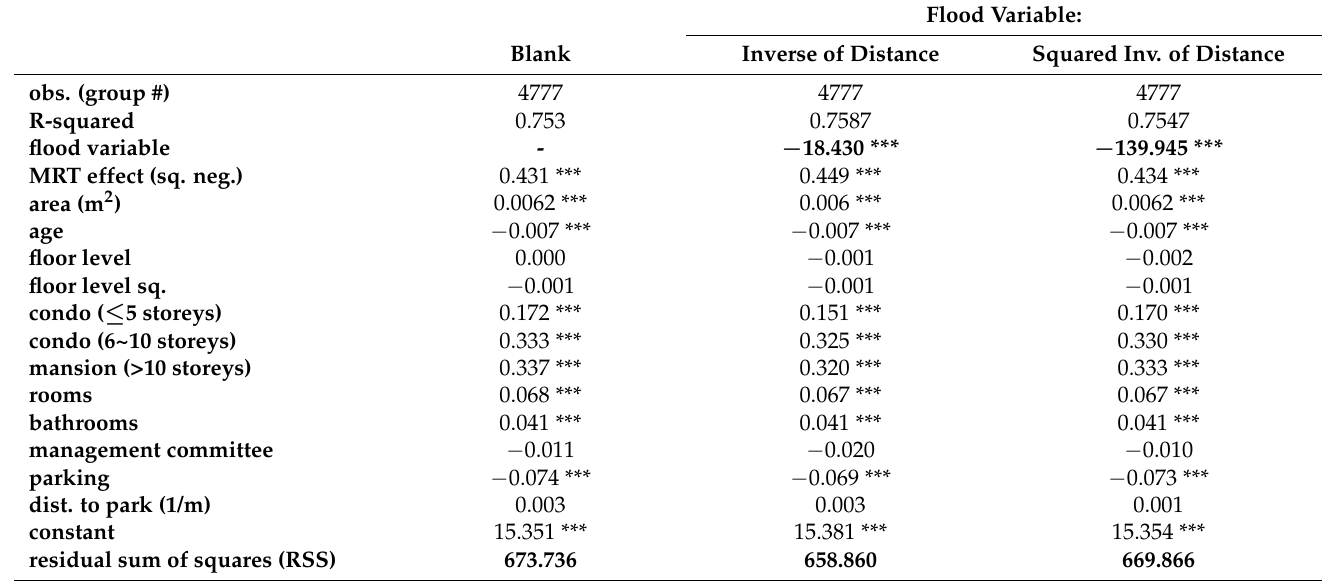
Table 3. Regression results for inversed distance-to-flood variable. Flood Variable: Blank Inverse of Distance Squared Inv. of